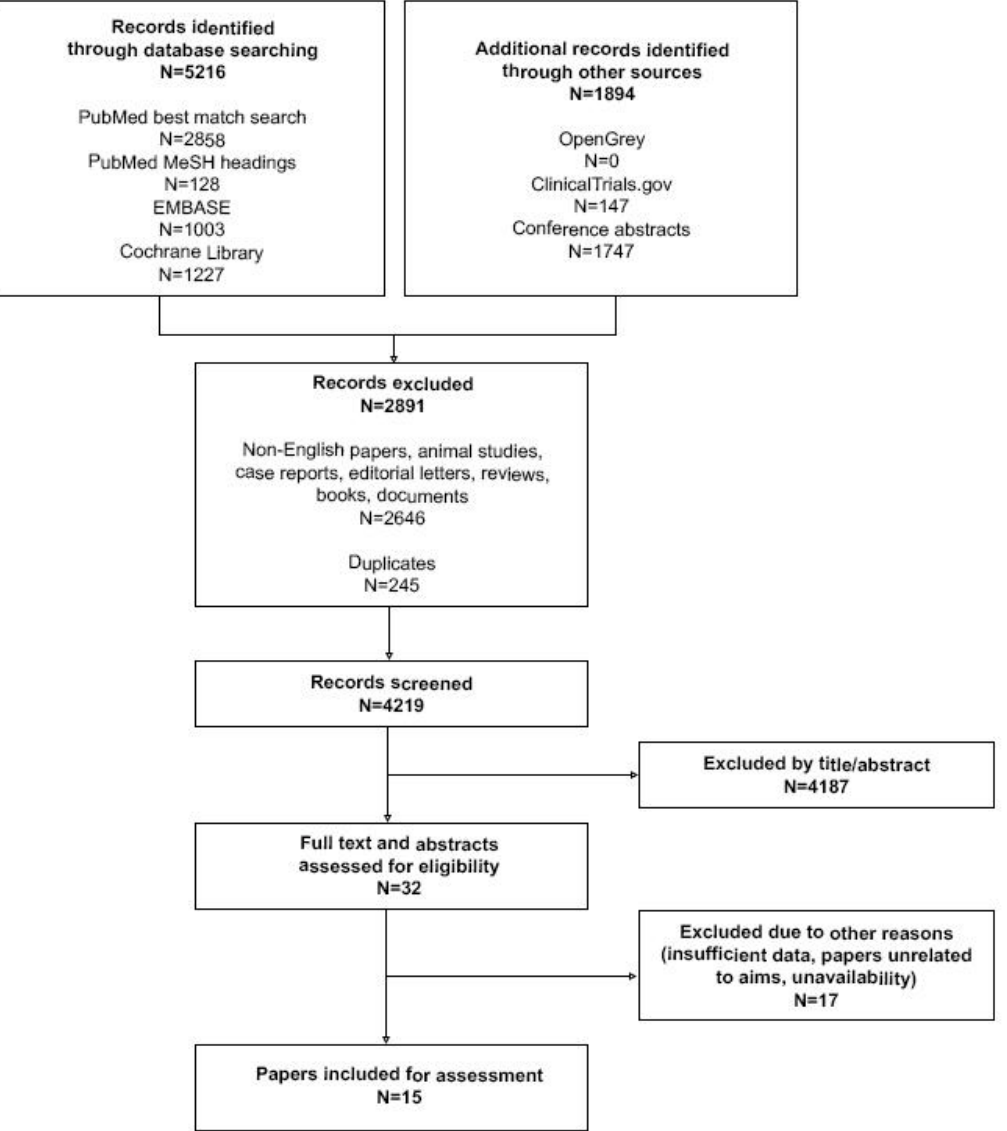
Figure 1. Articles selection process.